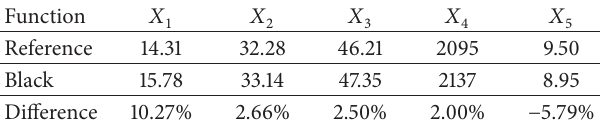
Table 8: Results obtained from the first model.